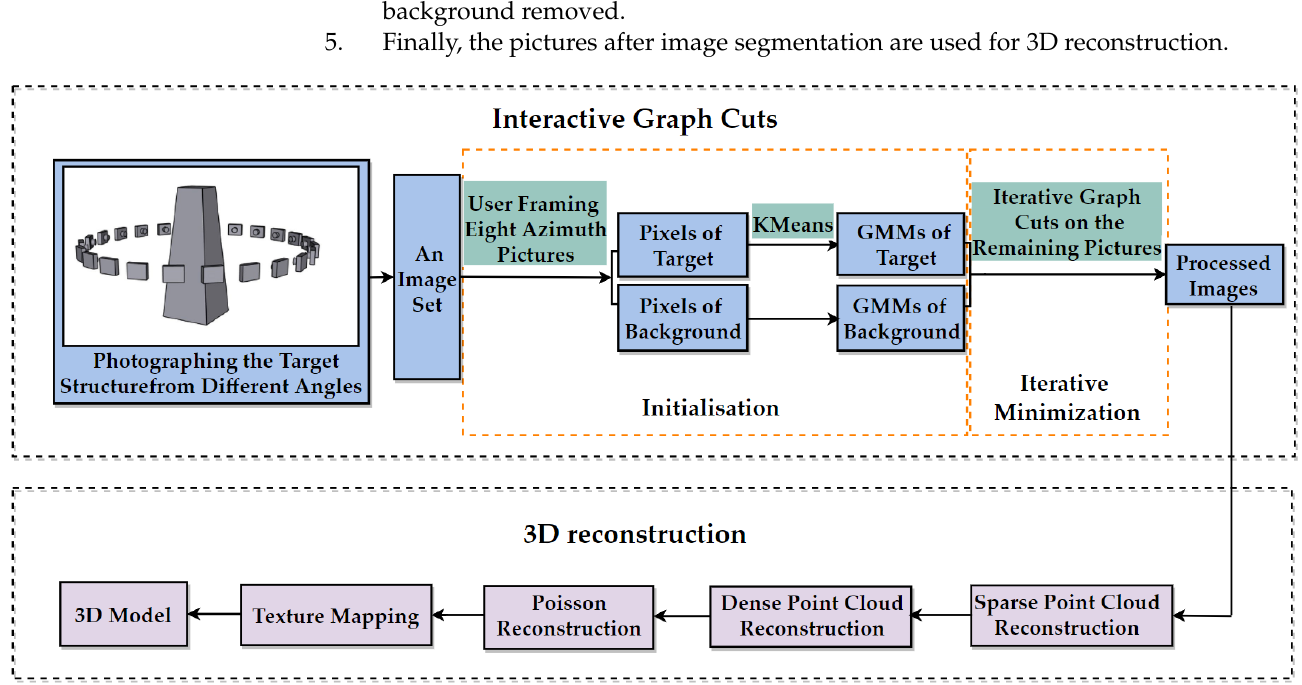
Figure 1. The flow chart of interactive graph cuts and 3D reconstruction.